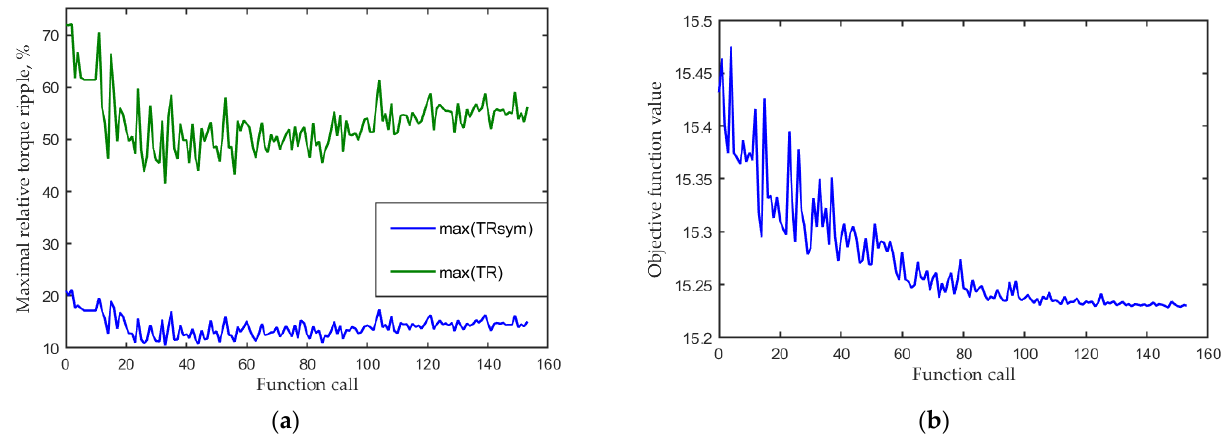
Figure 7. ( a ) Variation in the average efficiency during the optimization; ( b ) variation in the objective function during the optimization.